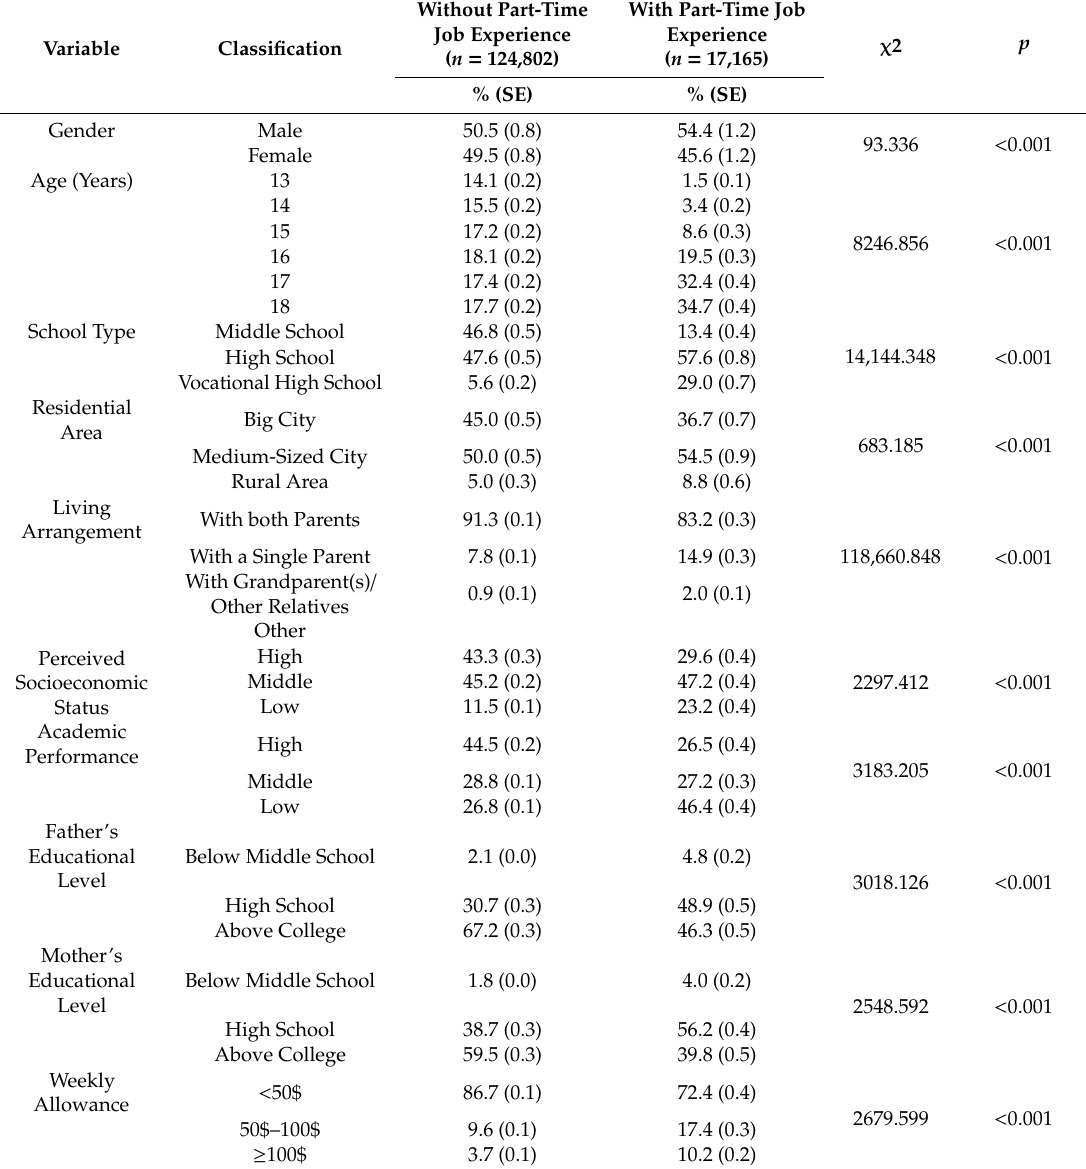
Table 1. Summary of demographic and socioeconomic characteristics in the groups with and without part-time job experience ( N =